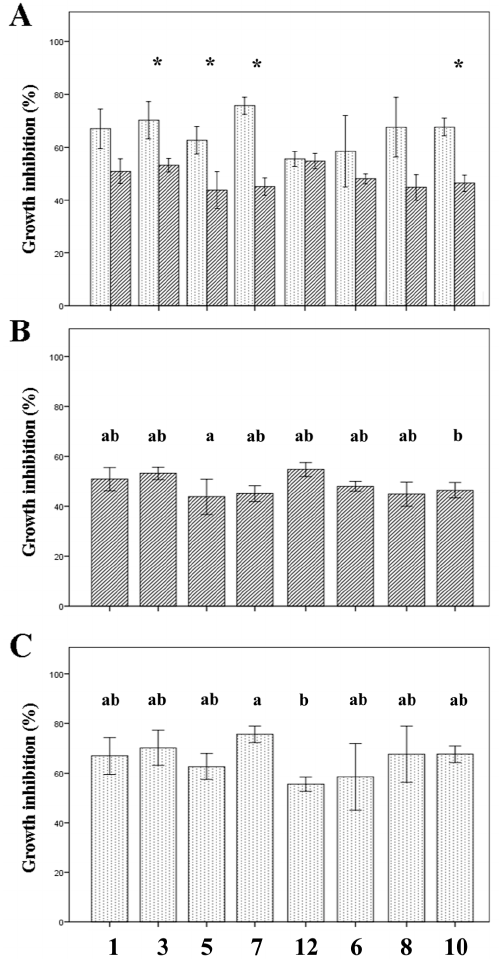
Figure 1. F. oxysporum growth inhibition by wine lactic acid bacteria (LAB). ( A ): Comparison in the e ffi cacy of the inhibition by the LAB strains when bacteria and fungus were inoculated simultaneously (dark bars) or when bacteria were allowed to grow for 48 h before inoculating the fungus (white bars). Values are mean ± SD. (*): Significant di ff erences ( p ≤ 0.05). ( B ): Comparison of the antifungal e ff ect of the di ff erent LAB strains when bacteria and fungus were inoculated simultaneously. ( C ): Comparison of the antifungal e ff ect of the di ff erent LAB strains when bacteria were cultured for 48 h before fungus inoculation. Values are mean ± SD. Di ff erent letters indicate significant di ff erences ( p ≤ 0.05). 1: LPAUV1, 3: LPAUV3, 5: LPAUV5, 7: LPAUV7, 12: LPAUV12, 6: LPLUV6, 8: LPLUV8, 10: